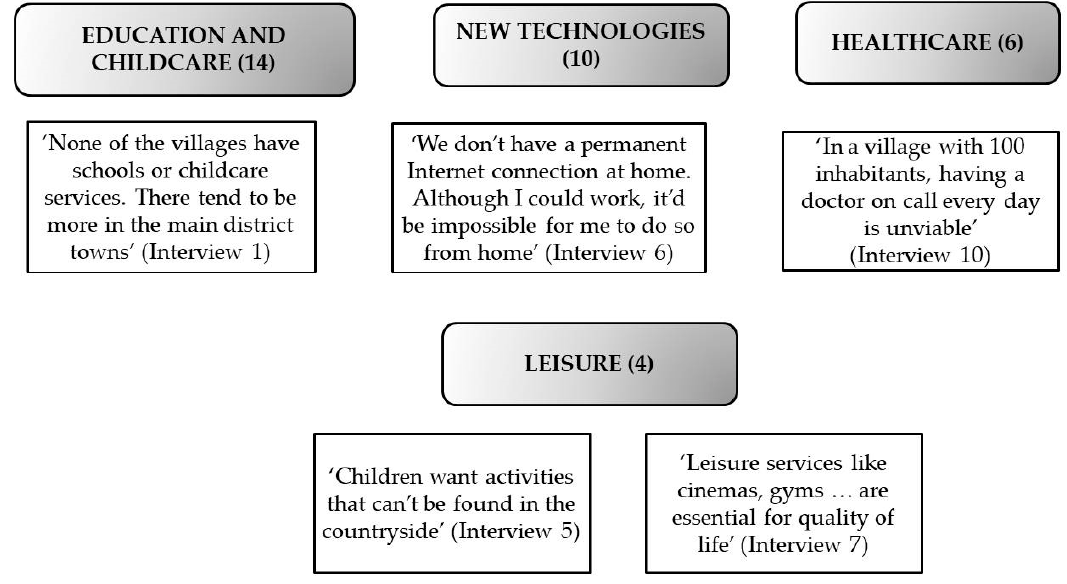
Figure 1. Services and rural exodus. Source: own elaboration. The number indicated in parentheses is the frequency of appearance of the corresponding codes in the transcripts of the interviews.